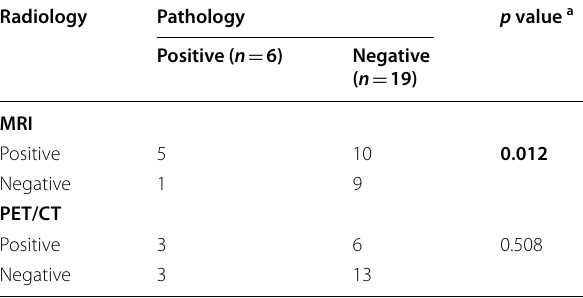
Bold means the parameter was significant p -value < 0.05 a